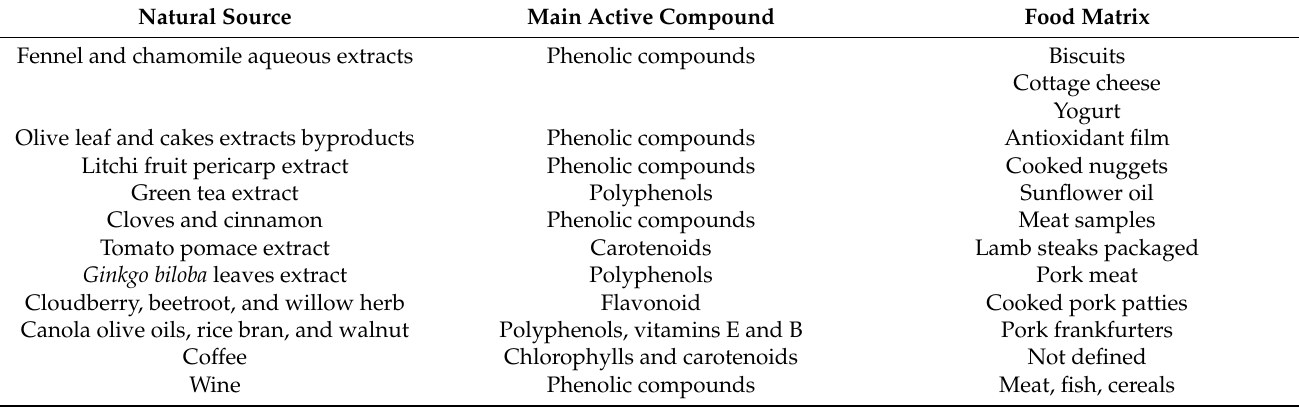
Table 1. Active compounds, natural sources of antioxidants, and their use in different food matrices [4].